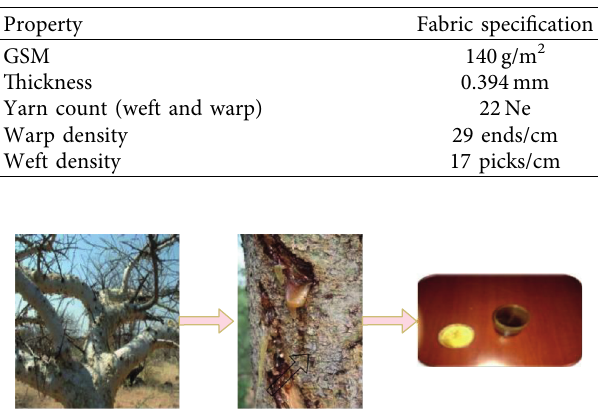
Figure 1: The extraction method of softener from Commiphora africana